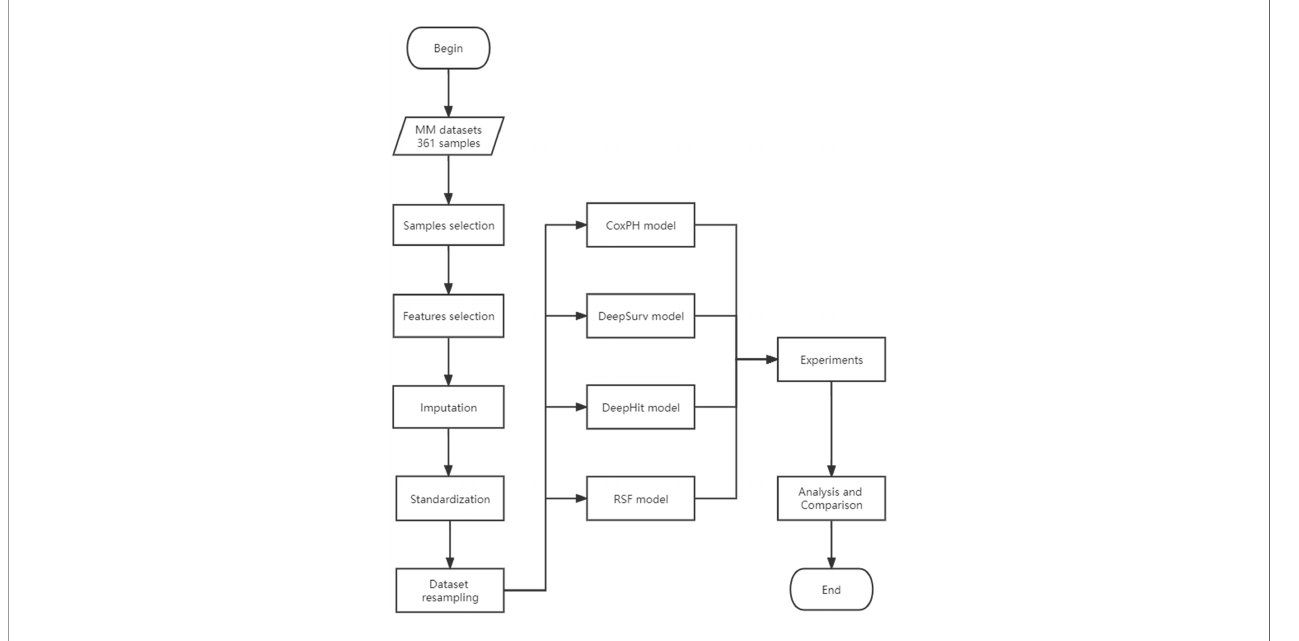
FIGURE 1 | Data Analysis